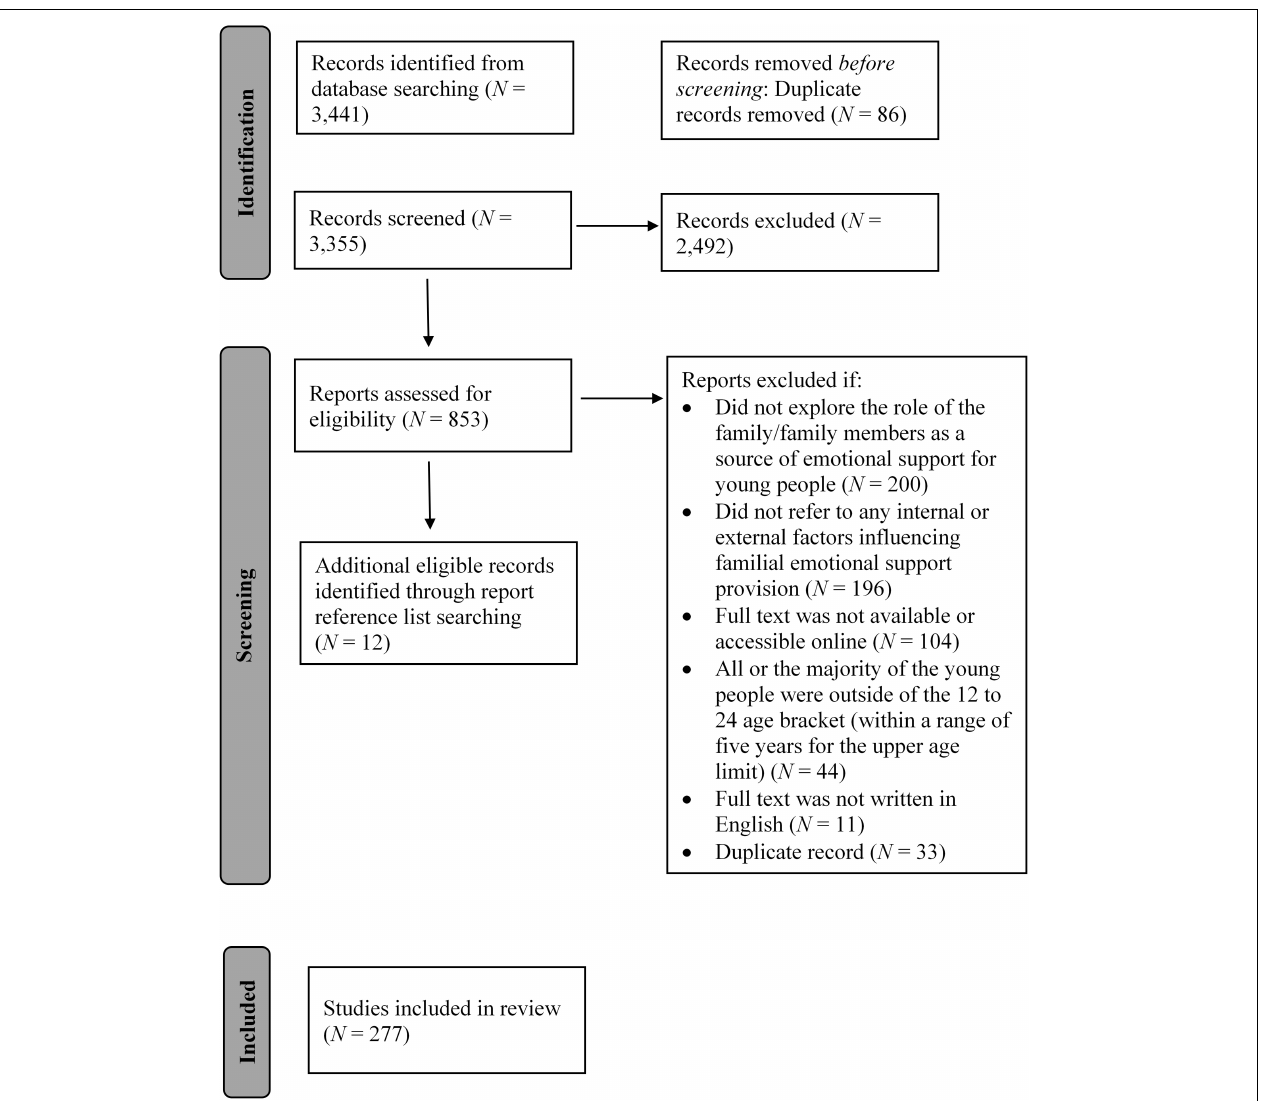
FIGURE 1 | PRISMA flow diagram illustrating the flow of information and identified records at each phase of the scoping review (Tricco et al., 2016,